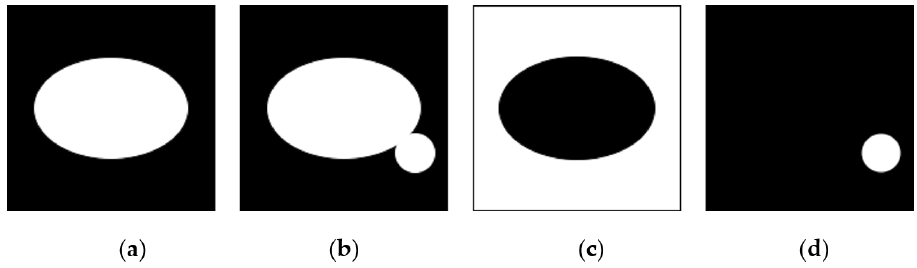
Figure 6. Binary maps of: ( a ) the ground truth, ( b ) the predicted output, ( c ) the inverted ground truth, and ( d ) the false positive area obtained by multiplying ( b , c ). Algorithm 1 Computation of dissimilarity coefficient for false negative DC FN and false Algorithm 2 Our proposed algorithm to update generator G with two different positive DC FP